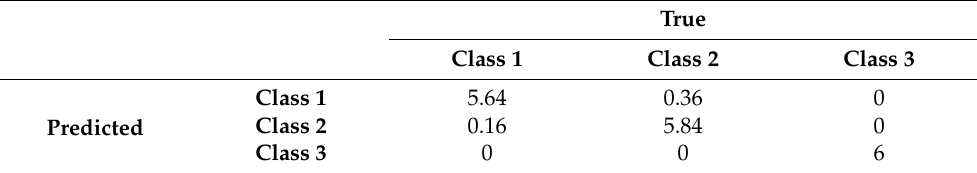
Table 7. Mean confusion matrix for MLP.